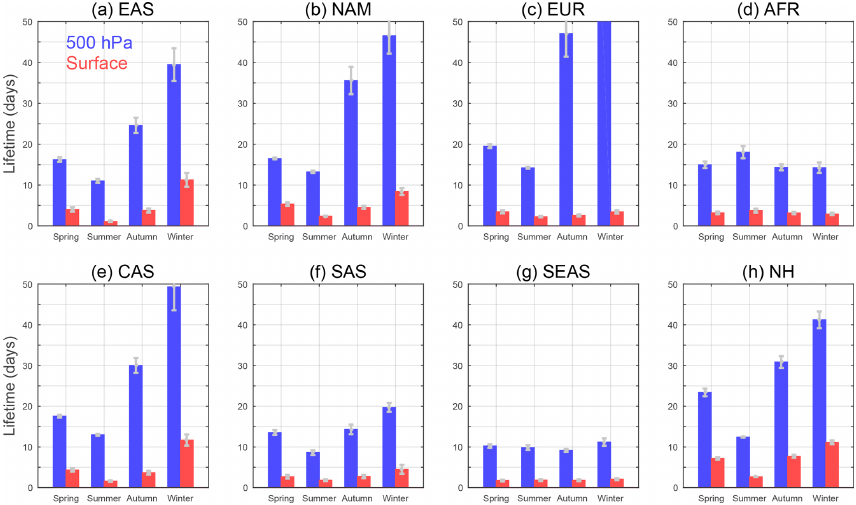
Figure 6. Ozone lifetime averaged in various regions in the middle troposphere (MT, 500hPa) and at the surface in 2005, calculated from the ozone dry deposition and chemical loss rate in GEOS-Chem simulations. The error bar is 4 times the standard error of the mean (equivalent to the 95% confidence limit of the mean). The regions are (a) East Asia (EAS), (b) North America (NAM), (c) Europe (EUR), (d) Africa (AFR), (e) central Asia (CAS), (f) South Asia (SAS), (g) South-east Asia (SEAS), and (h) the Northern Hemisphere